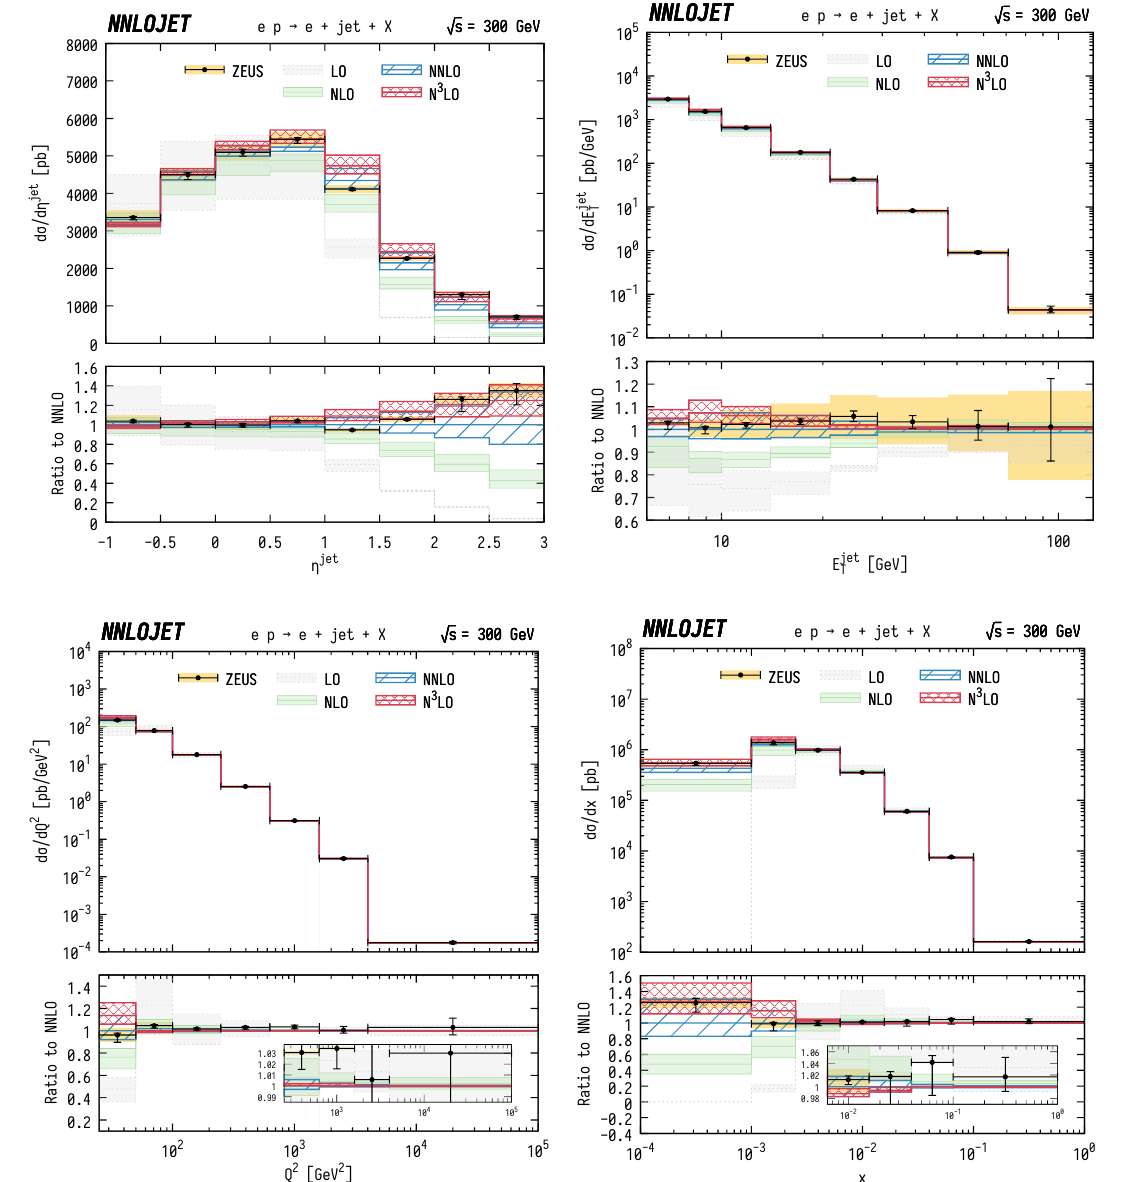
Figure 2 . Kinematical distributions in single inclusive jet production in deep inelastic scattering up to N 3 LO in QCD, compared to ZEUS measurements [89]. The error bars on the data represent the statistical and systematic uncertainties added in quadrature; the uncertainty in the absolute energy scale of the jets is shown separately as a shaded yellow